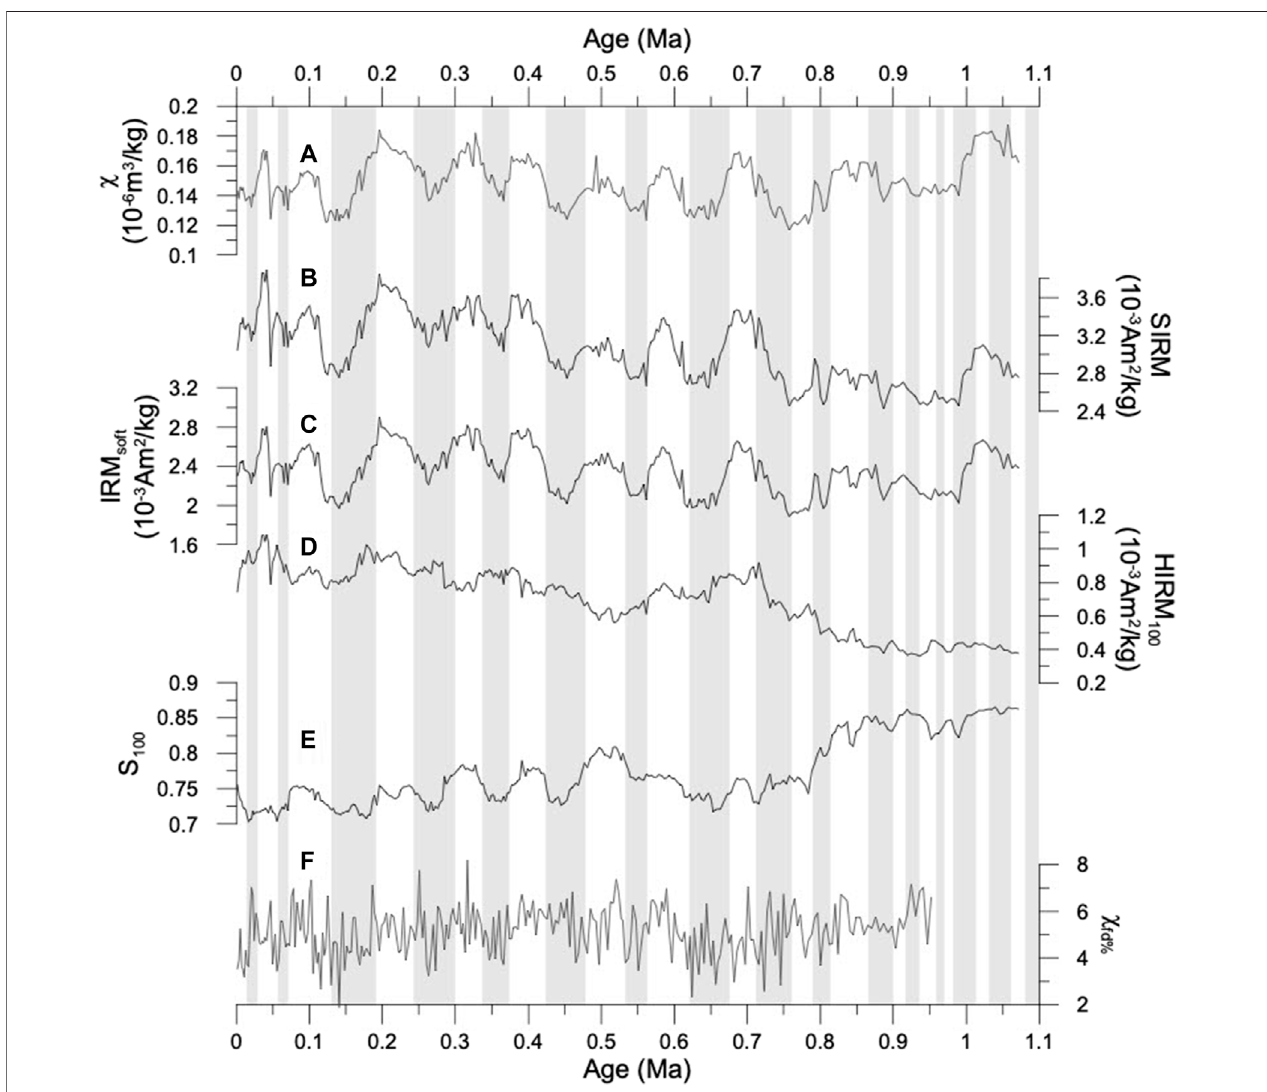
FIGURE 2 | Temporal variation of concentration-related magnetic parameters of NPGP1401-2A. (A) χ , magnetic susceptibility (Shin et al., 2019); (B) SIRM, saturationisothermalremanentmagnetization(Shinetal.,2019); (C) IRM soft ,softIRMfraction(coercivityof < 100 mT); (D) HIRM 100 ,hardIRM(coercivityof > 100 mT); (E) S-ratio (S 100 ) and (F) χ fd% , frequency-dependent magnetic susceptibility. The grey bars indicate glacial